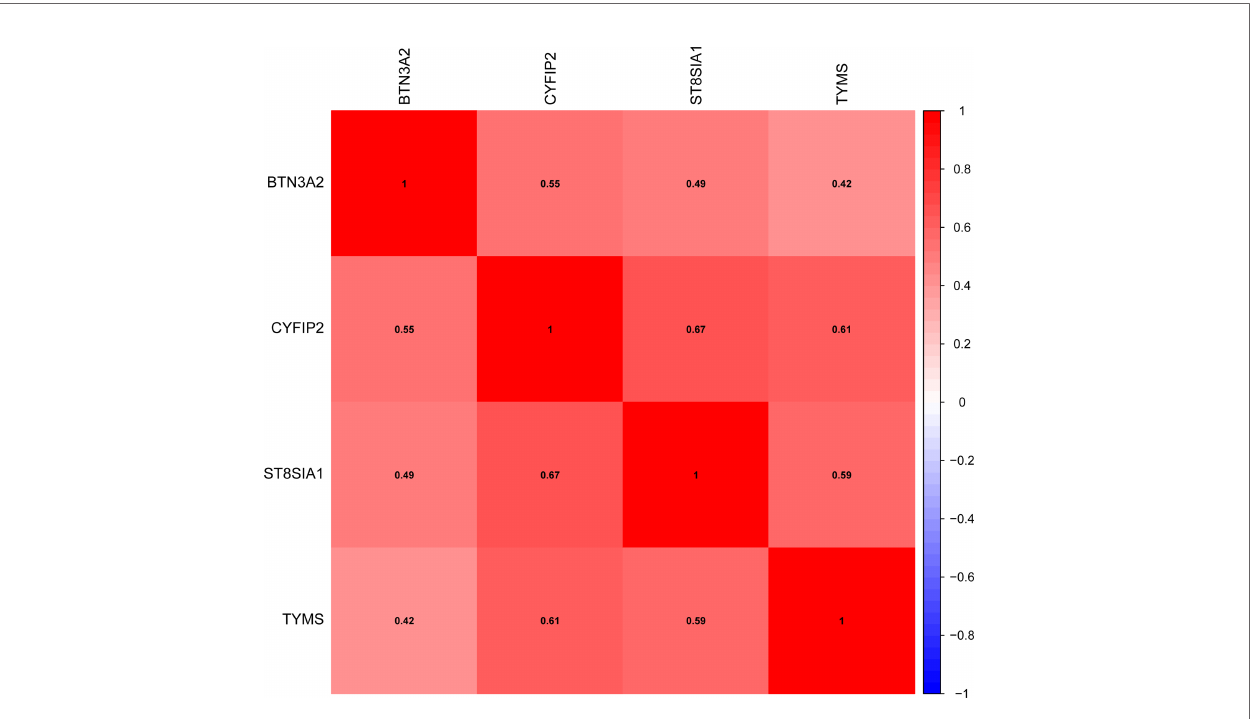
FIGURE 5 | Correlation between trait